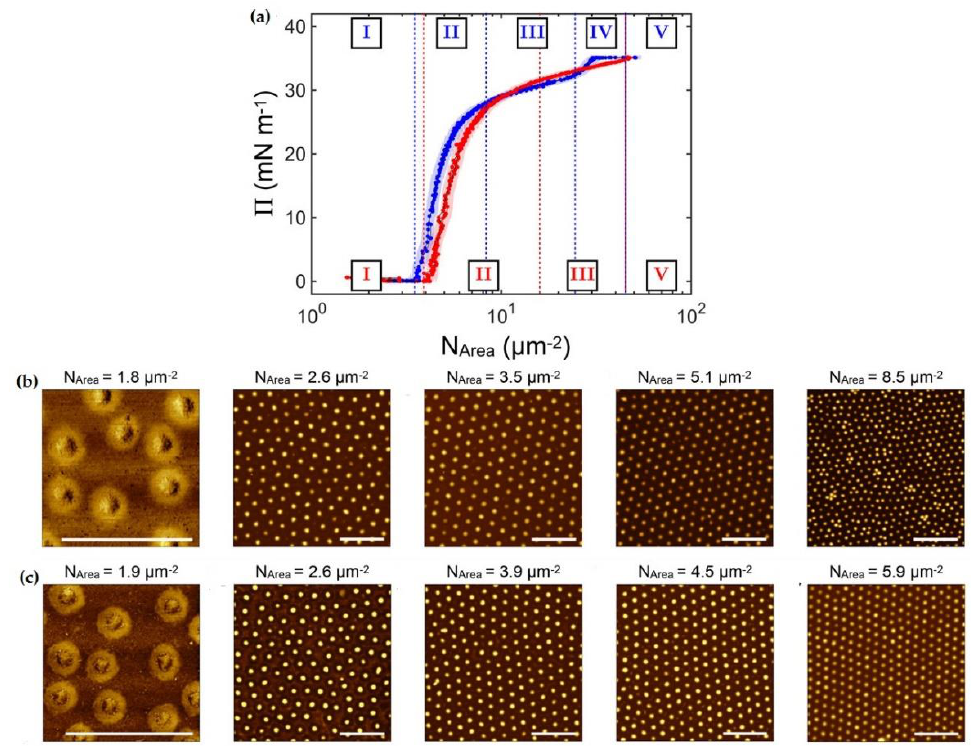
Figure 3. ( a ) Surface pressure ( Π ) vs. number of microgels per area unit isotherms for PNIPAM microgels at a water/decane interface. The blue and red curves correspond to the isotherms obtained at 20 °C (below the volume phase transition temperature) and 40 °C (above the volume phase transition), respectively. The dashed lines indicate the onset of the different regimes, which are indicated by roman numerals in the corresponding colors. ( b ) Atomic Force Microscopy images of Langmuir – Blodgett deposits obtained for monolayers of PNIPAM microgels at a water/decane interface below the volume phase transition temperature (at 20 °C). ( c ) Atomic Force Microscopy images of Langmuir – Blodgett deposits obtained for monolayers of PNIPAM microgels at a water/decane interface above the volume phase transition temperature (at 40 °C). Adapted from Bochenek et al. [45] with permission from the American Chemical Society, Copyright (2019).